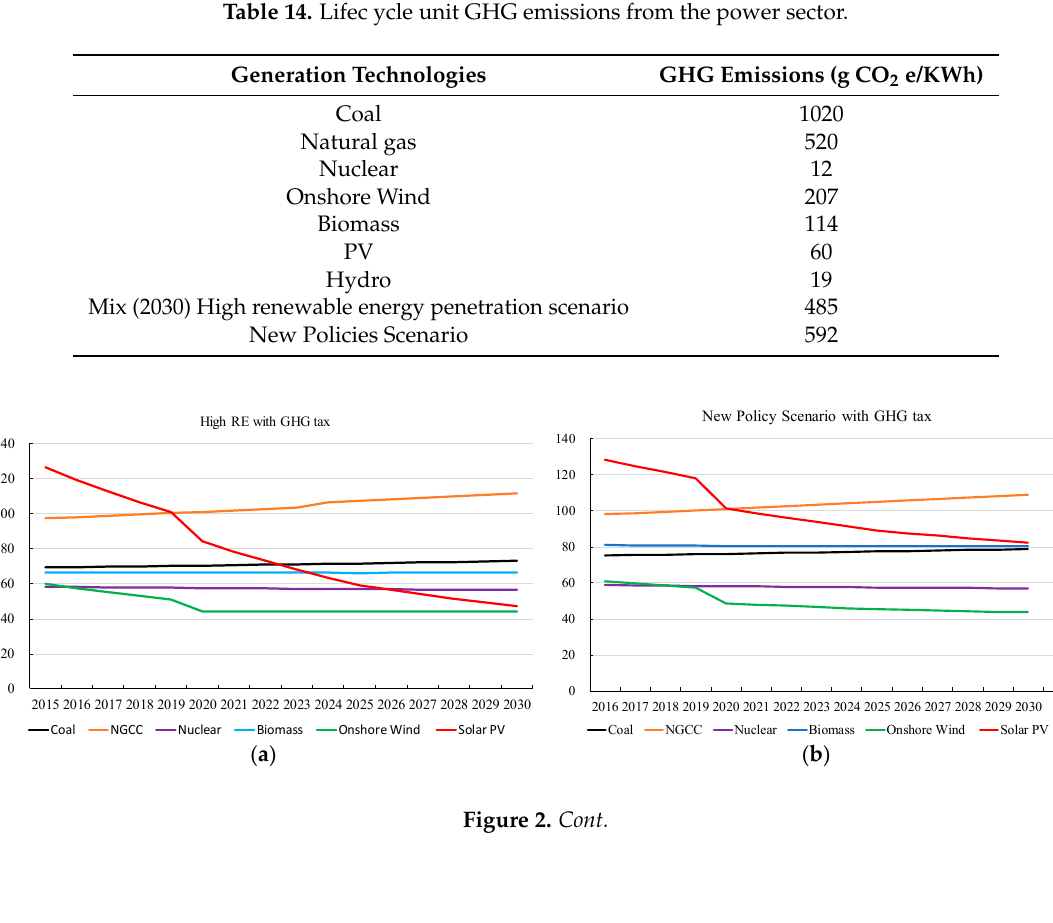
Table 14. Lifec ycle unit GHG emissions from the power sector.